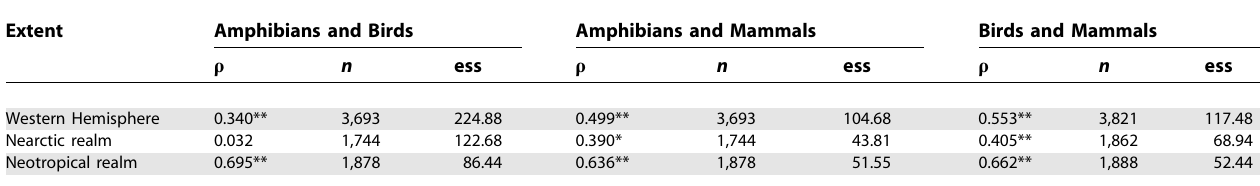
Table 1. Correlations in Beta-Diversity ( b sim-d ) within the Western Hemisphere, Nearctic Realm, and Neotropical Realm Extent